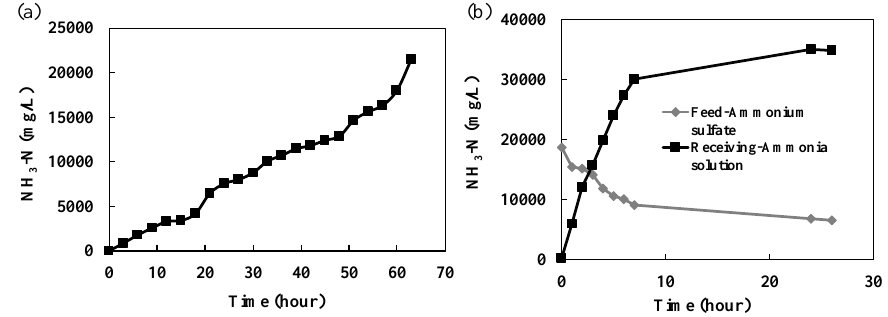
Figure 8. ( a ) Ammonia accumulation in (NH 4 ) 2 SO 4 solution as a function of time; ( b ) The NH 3 -N concentrations in both feed and receiving solutions as a function of time using the modified MD (receiving solution: 10 °C ice deionized water).